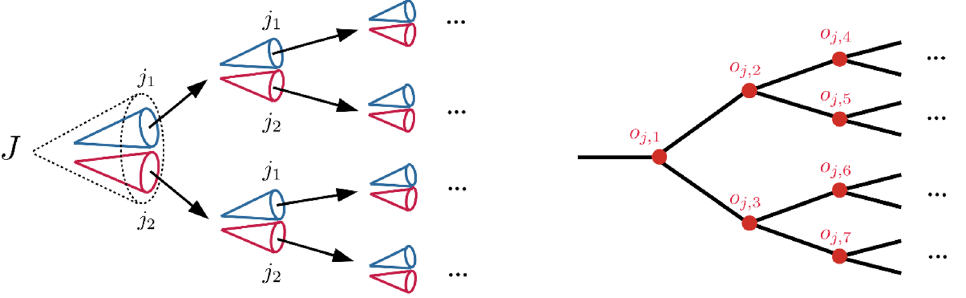
Figure 4 . In the left plot we show schematically how the sequential unclustering algorithm proceeds, with the whole jet J being repeatedly separated into two subjets ( j 1 and j 2 with m j m j ). In the right plot we then show how the feature representation of the data maps onto this 2 unclustering, with each o j;i being mapped to a node in the unclustering tree. Note that the ordering of these o j;i terms with a single jet does not